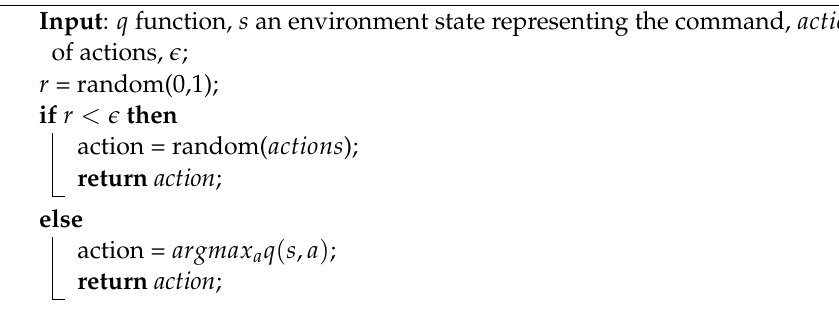
Algorithm 2: Action selection using the (cid:101) -greedy policy to balance between exploration and